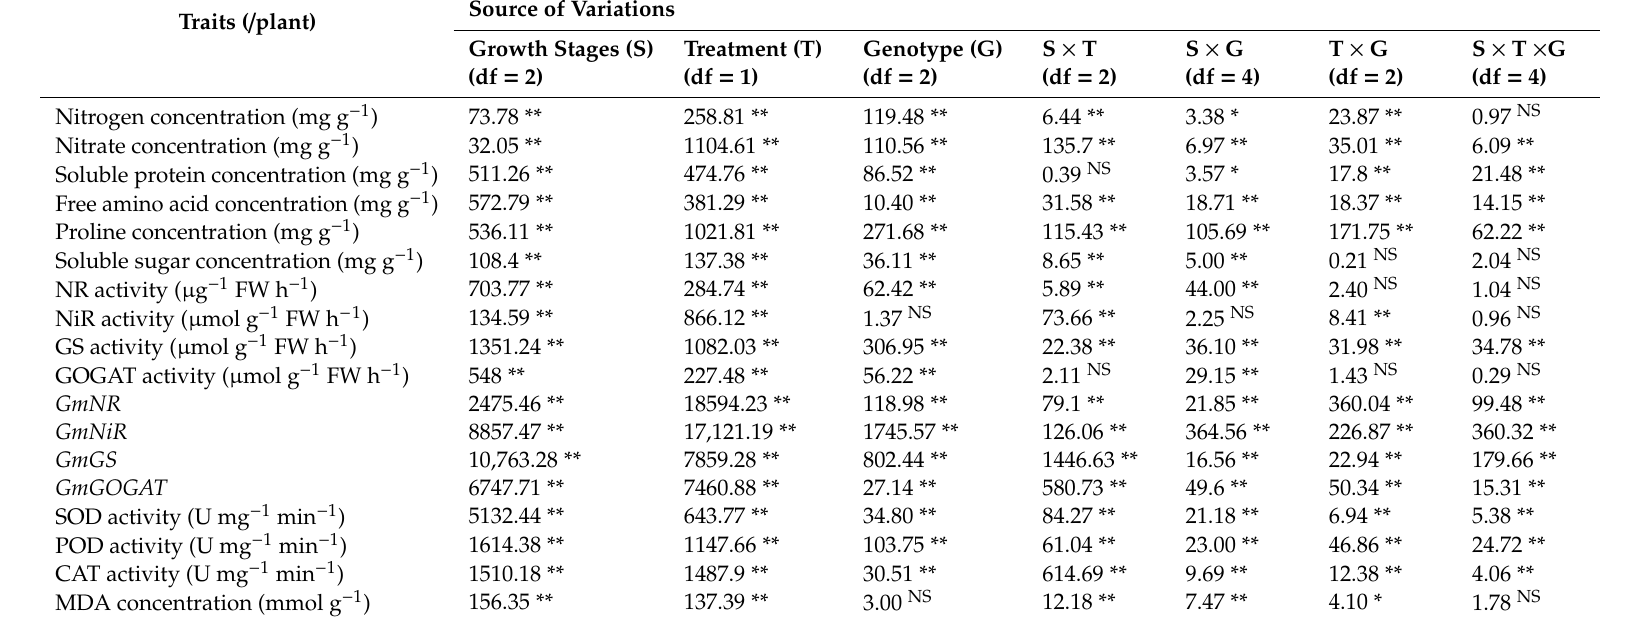
Table 4. Analysis of variance of physiological